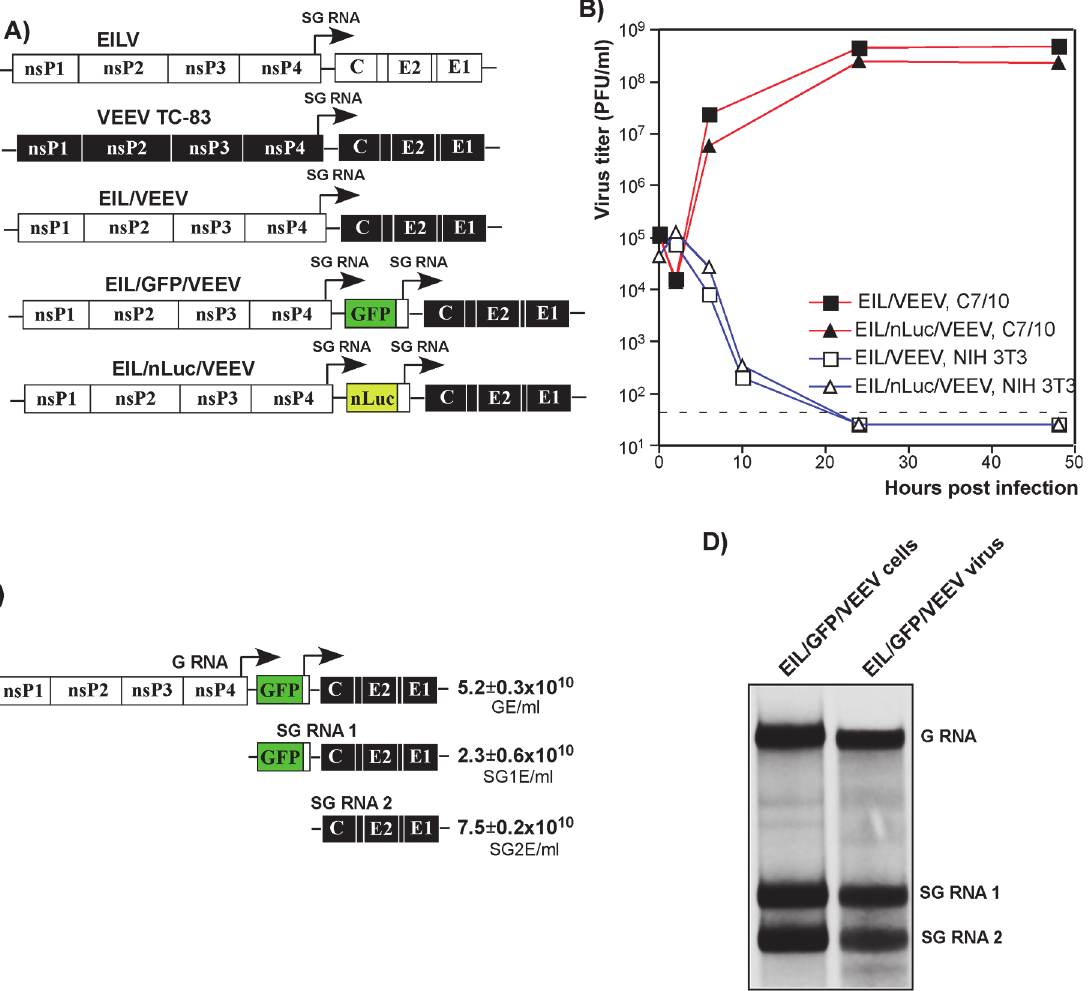
Fig 1. Chimeric EIL/VEEV viruses do not replicate in vertebrate cells, and package subgenomic RNAs into viral particles in mosquito cells. (A) The schematic representation of EILV, VEEV TC-83 and recombinant viral genomes. (B) Replication of EIL/VEEV and EIL/nLuc/VEEV in C7/10 and NIH 3T3 cells. Cells were infected at an MOI of 20 PFU/cell. Media were harvested at the indicated times post infection, and titers were determined by plaque assay on C7/10 cells. (C) Concentrations of genomic RNA, SG RNA 1 and SG RNA 2 in the sample of EIL/GFP/VEEV harvested at 48 h PI of C7/10 cells. The number of copies per ml of virus were determined by RT-qPCR using primers specific to EILV nsP2, GFP and VEEV E2 genes as described in Materials and Methods. (D) C7/10 cells were infected with EIL/GFP/VEEV at an MOI of 20 PFU/cell, and viral RNA were labeled with [ 3 H]uridine between 16 and 24 h post infection. RNAs were isolated from both the cells and the released viral particles and analyzed by agarose gel electrophoresis in denaturing conditions.